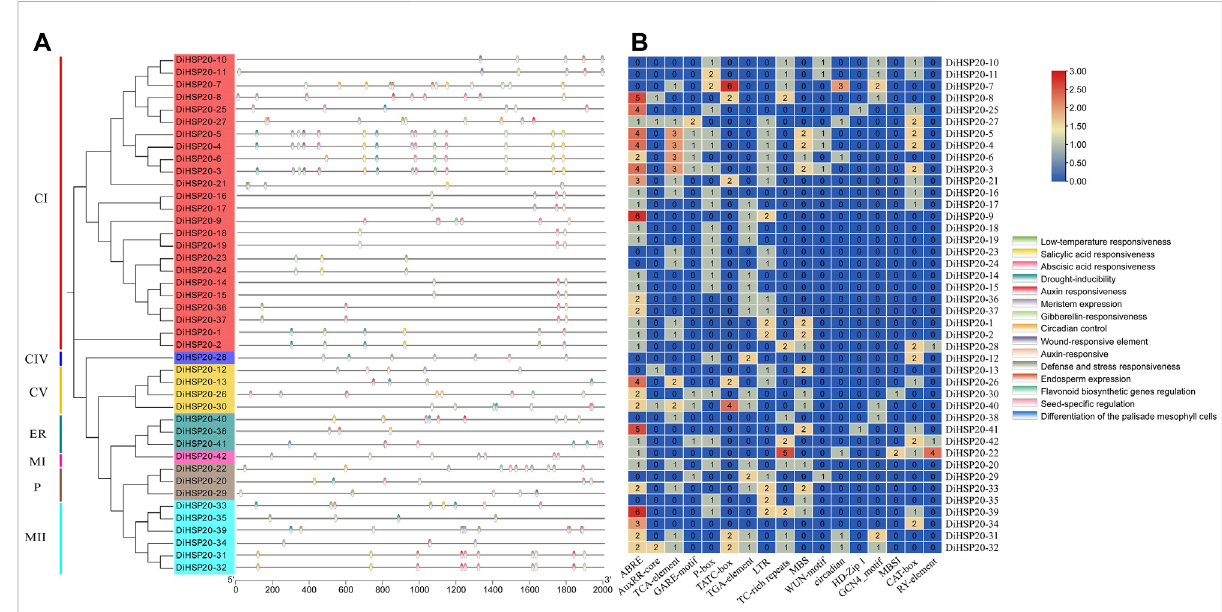
FIGURE 6 Cis-elements evaluation of the DiHSP20 gene promoter regions (A) The distinct colors and numbers in the DiHSP20 genes showed the variety of different promoter elements. (B) Different kinds of cis-elements and relative positions in every DiHSP20 gene are represented by colored